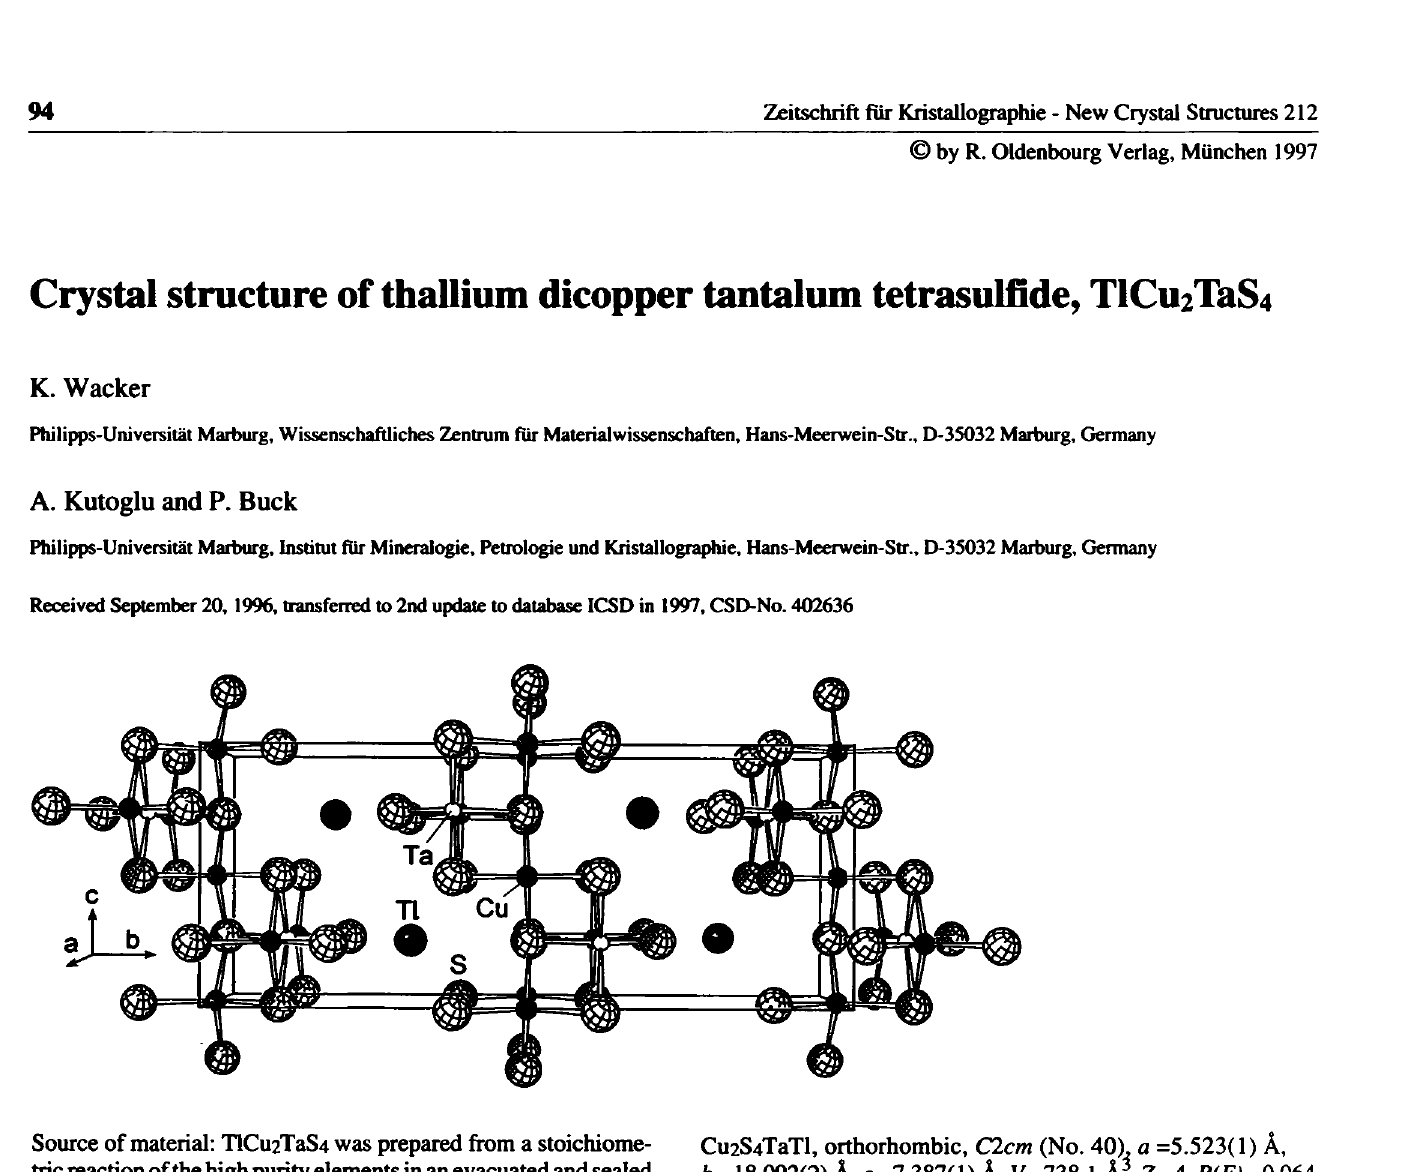
Table 1. Parameters used for the X-ray data collection Crystal: